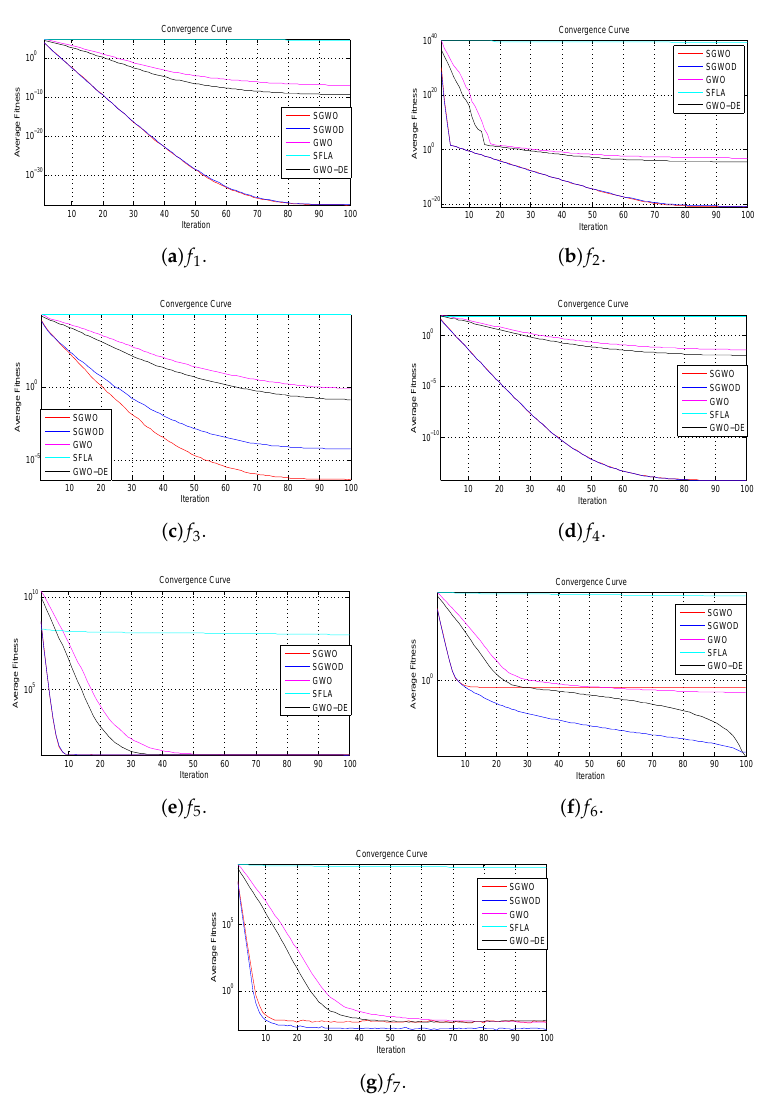
Figure 6. Convergence curves of unimodal benchmark